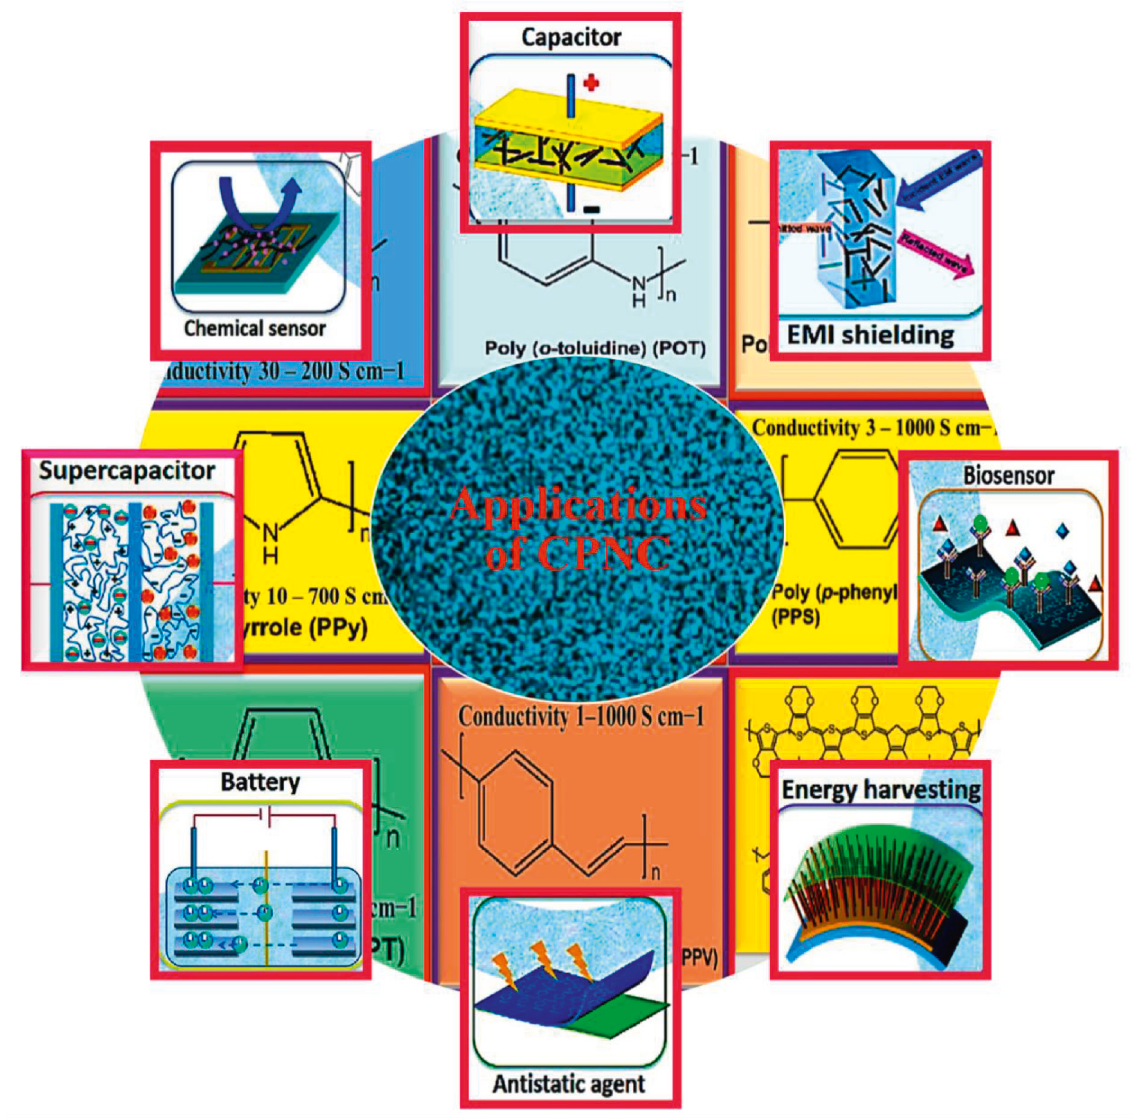
Figure 8: Illumination of different conjugated conductive polymer nanocomposites in innovative applications [84].